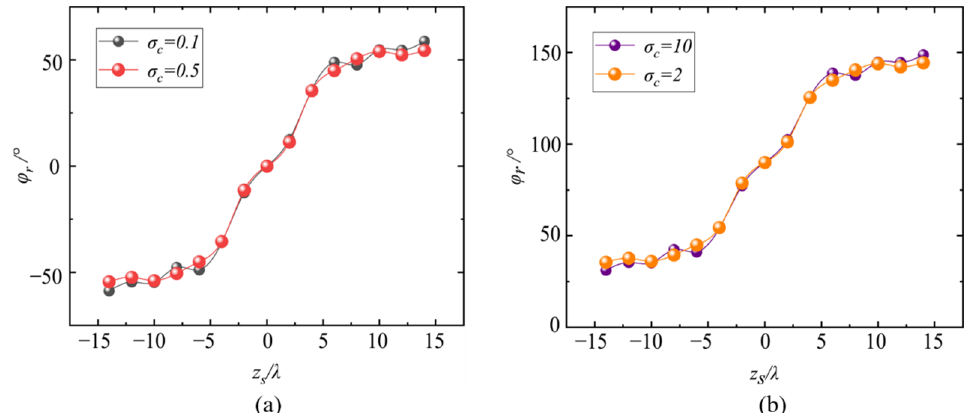
Figure 6. Variation in the rotational angle 𝜑 (cid:3045) for the longitudinal energy flow 𝑝 (cid:3053) with the beam propagation. Here, ( a ) 𝜎 (cid:3030) = 0.1,0.5; ( b ) 𝜎 (cid:3030) = 2, 10. In both plots 𝑙 = 2 .